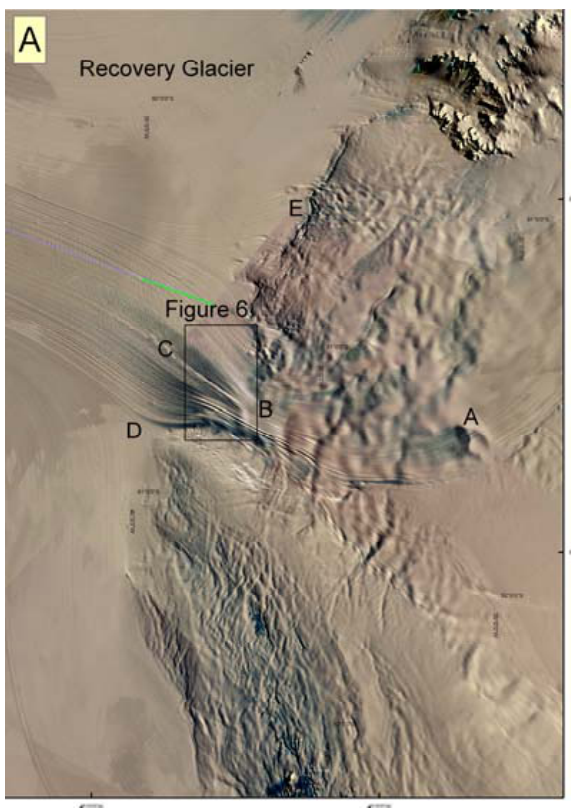
Fig. 5b. Interpretation of key surface structures. Point A indi- cates disruption to otherwise persistent longitudinal surface struc- Figure 5B. Interpretation of key Figure 5B. Interpretation of key tures in a crevassed zone. Points B and C indicate converging and surface structures. Point A diverging longitudinal surface structures respectively as the glacier surface structures. Point A flows through a narrow constriction. Point D indicates the zone of indicates disruption to otherwise indicates disruption to otherwise convergence between Recovery Glacier and Support Force Glacier. persistent longitudinal surface Point E indicates the initiation of longitudinal surface structures at persistent longitudinal surface the base of an inferred structures in a crevassed zone. structures in a crevassed zone. Points B and C indicate converging Points B and C indicate converging and diverging longitudinal surface and diverging longitudinal surface structures respectively as the structures respectively as the glacier flows through narrow glacier flows through a narrow constriction. Point D indicates the constriction. Point D indicates the zone of convergence between zone of convergence between Recovery Glacier and Support Recovery Glacier and Support Force Glacier. Point E indicates the Force Glacier. Point E indicates the initiation of longitudinal surface initiation of longitudinal surface structures at the base of an inferred structures at the base of an inferred icefall. icefall.